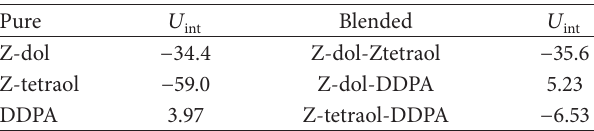
Table 3: The interaction energies for pure and blended PFPE end groups. All units are in